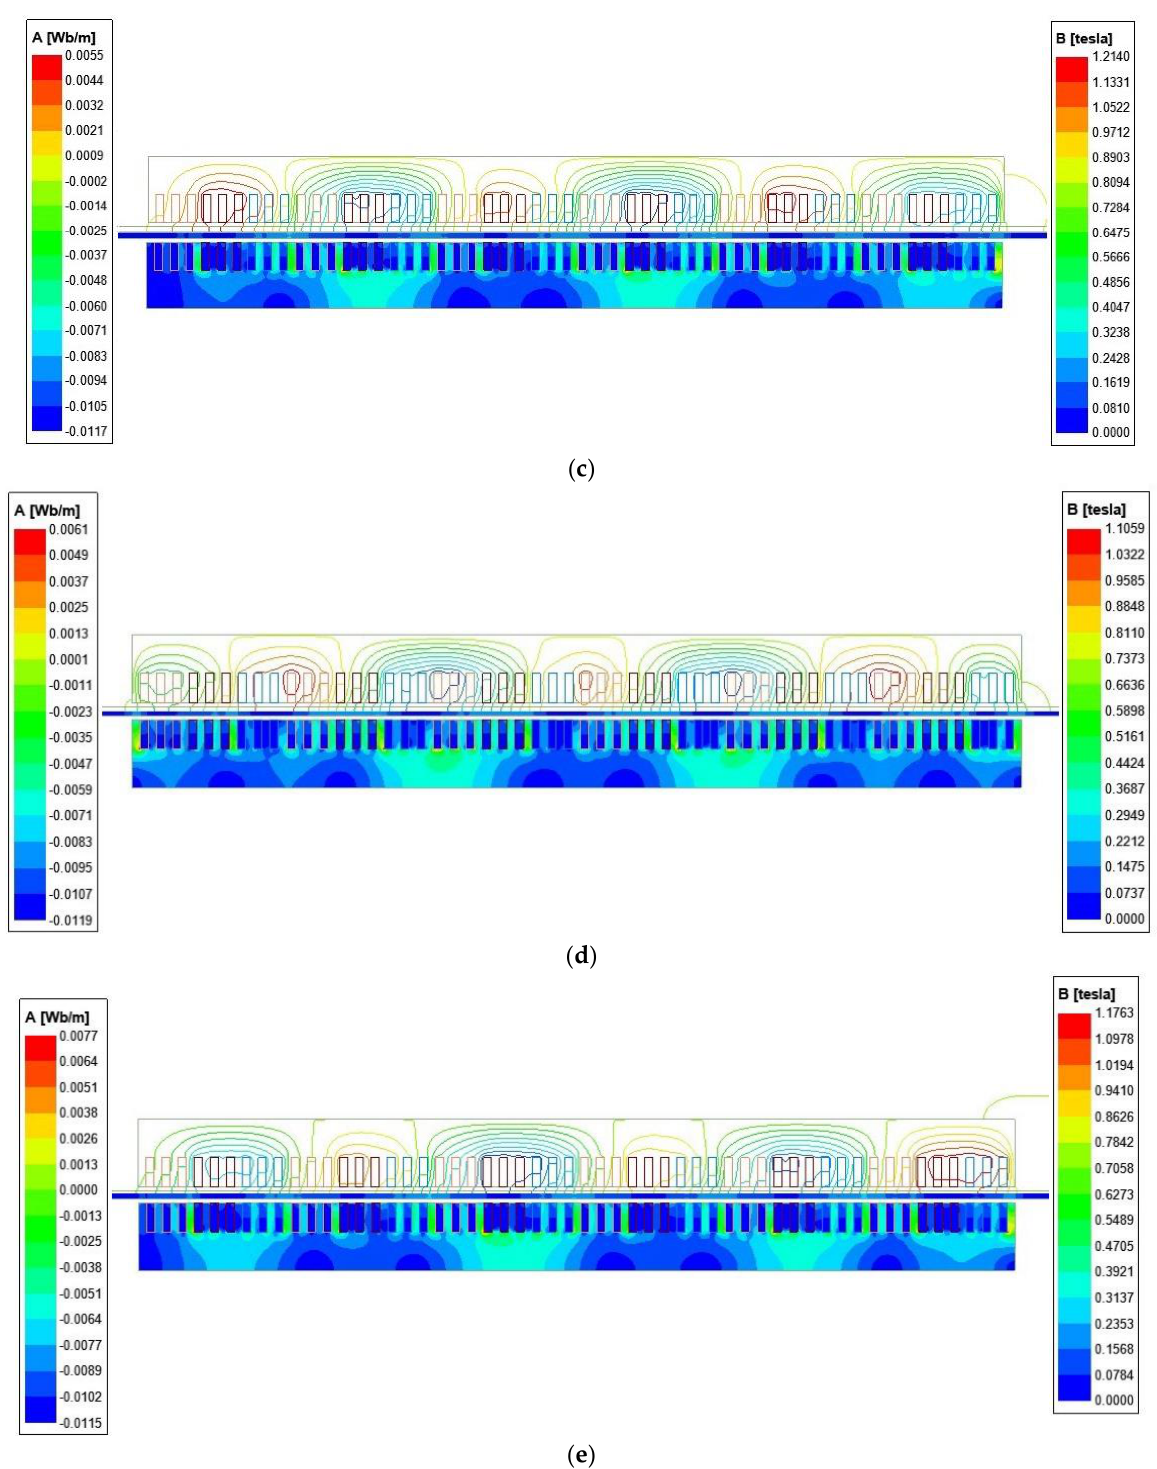
Figure 7. Distribution of flux lines and flux density when SP-DLIM is running in a steady state at ( a ) t = 0; ( b ) t = 0.25 T; ( c ) t = 0.5 T; ( d ) t = 0.75 T; ( e ) t = T. ( a ) Flux lines and flux density distribution at t = 0. ( b ) Flux lines and flux density distribution at t = 0.25 T. ( c ) Flux lines and flux density distribution at t = 0.5 T. ( d ) Flux lines and flux density distribution at t = 0.75 T. ( e ) Flux lines and flux density distribution at t = T.